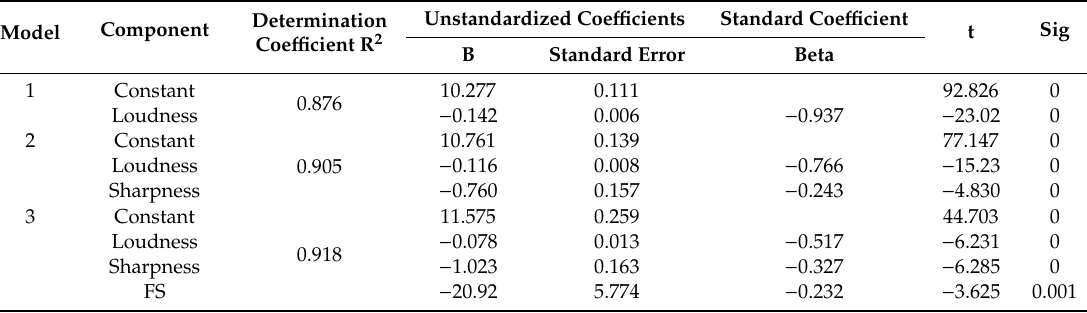
Table 4. Results of the regression